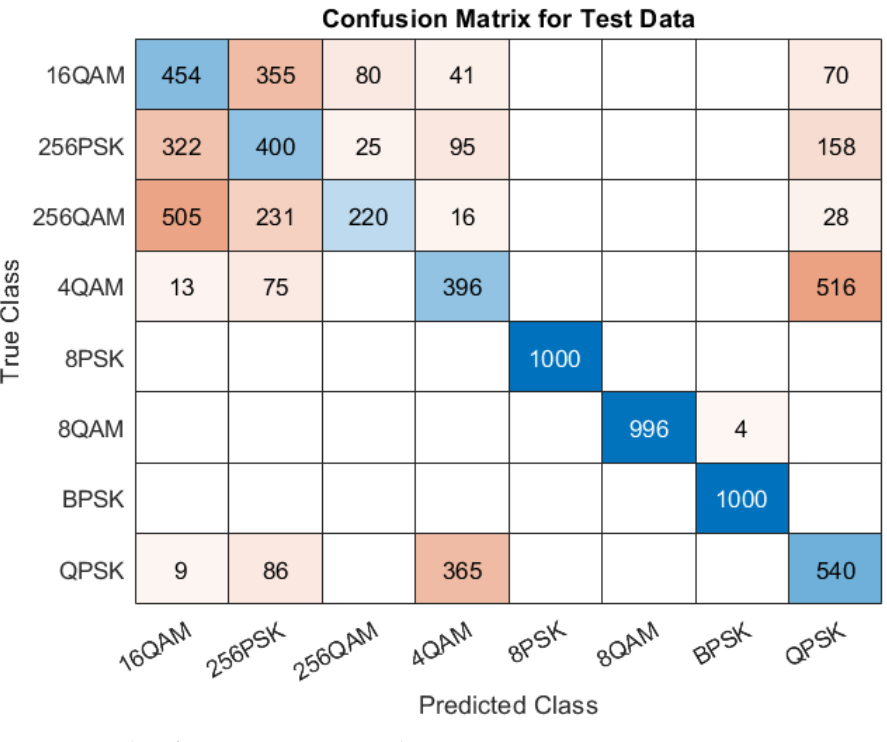
Figure 12. Classification Accuracy at 0